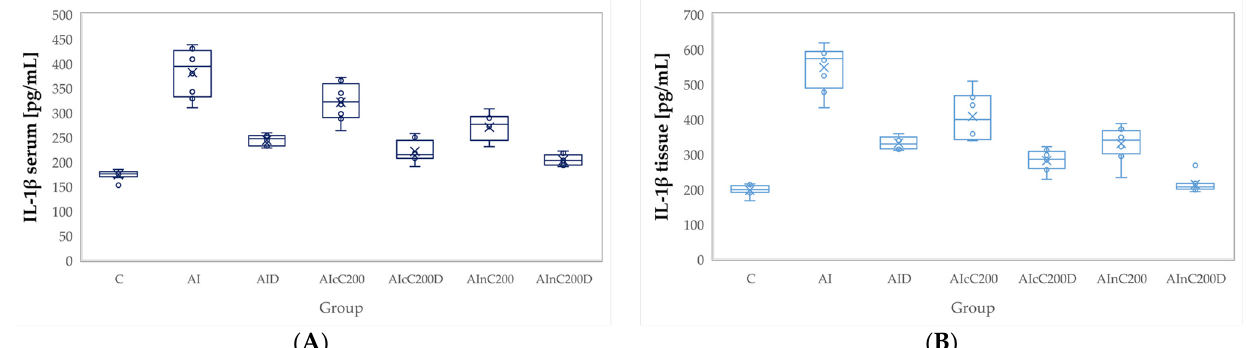
Figure 6. Variation by groups of IL-1 β (Interleukin 1 β ): ( A ) in the plasma ( B ) in the tissue. C—control; AI—Acute inflammation; D—Diclofenac; cC—conventional curcumin solution (200 mg/kg b.w.); nC—curcumin nanoparticles solution (200 mg/kg b.w.).